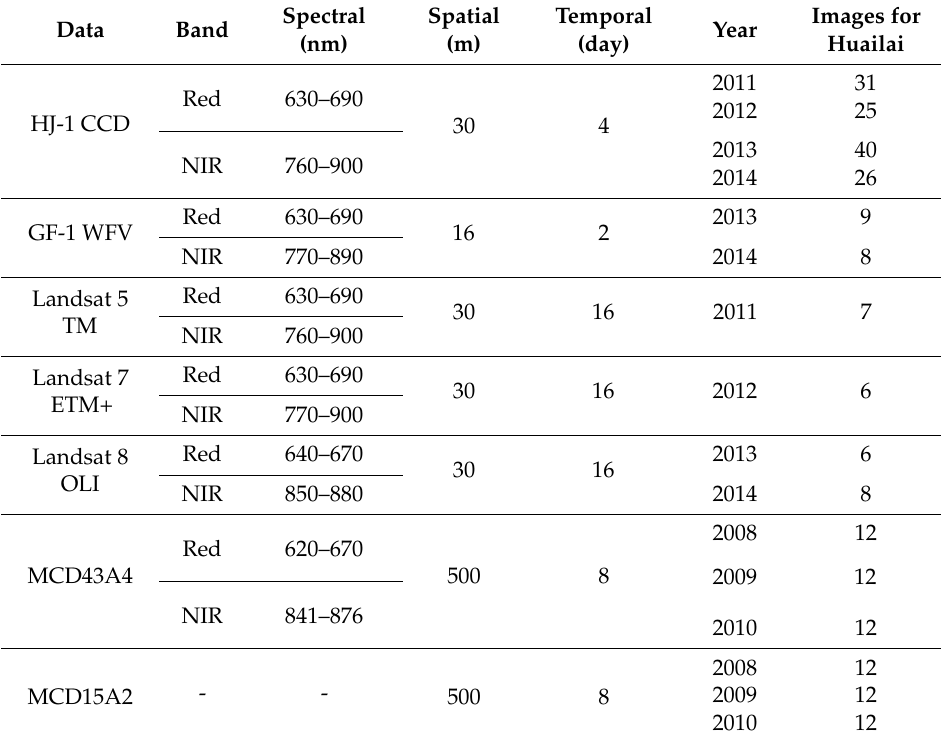
Table 1. Summary of different types of satellite images used in